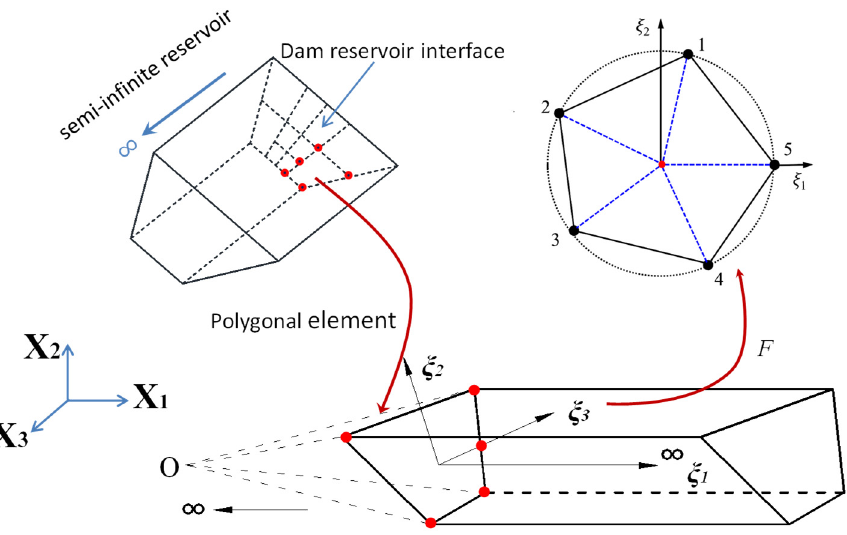
Figure 8. Polygonal semi-infinite prismatic reservoir element.